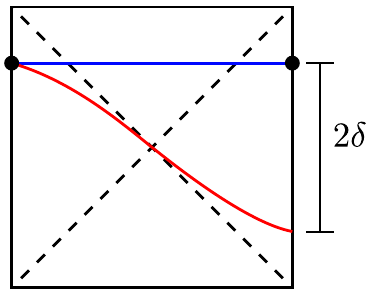
Figure 3 . Di(cid:11)erent time slices of the wormhole solution can correspond to di(cid:11)erent initial data for the JT gravity. Here the (cid:12)rst and second slices are di(cid:11)erent points in phase space, while the (cid:12)rst and third are the same since they di(cid:11)er by evolution by H R (cid:0) H L .